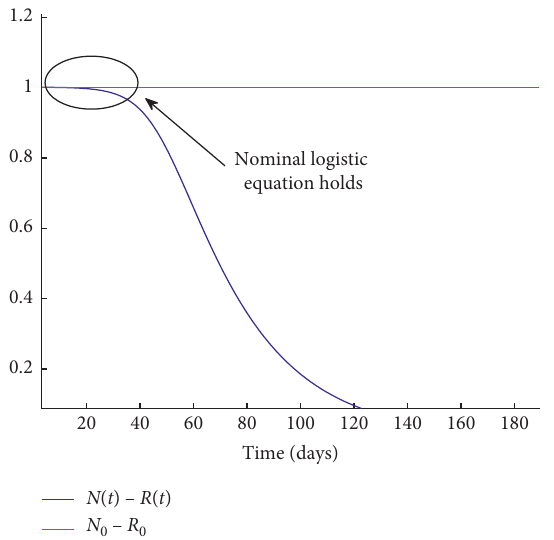
Figure 6: Evolution of (N(t) − R(t)) with time.